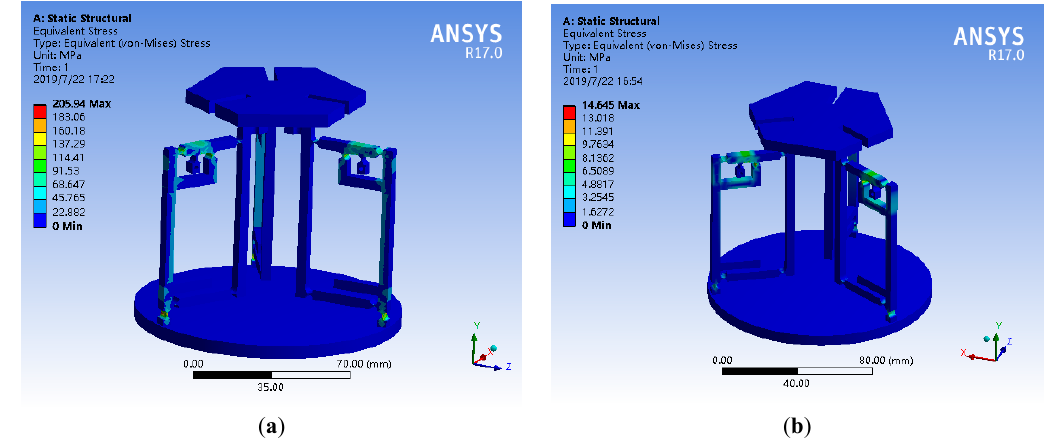
Figure 9. Static simulation of maximum stress value. ( a ) Three branches chain loaded displacement of 30 μ m; ( b ) Three branches chain loaded thrust of 50 N.